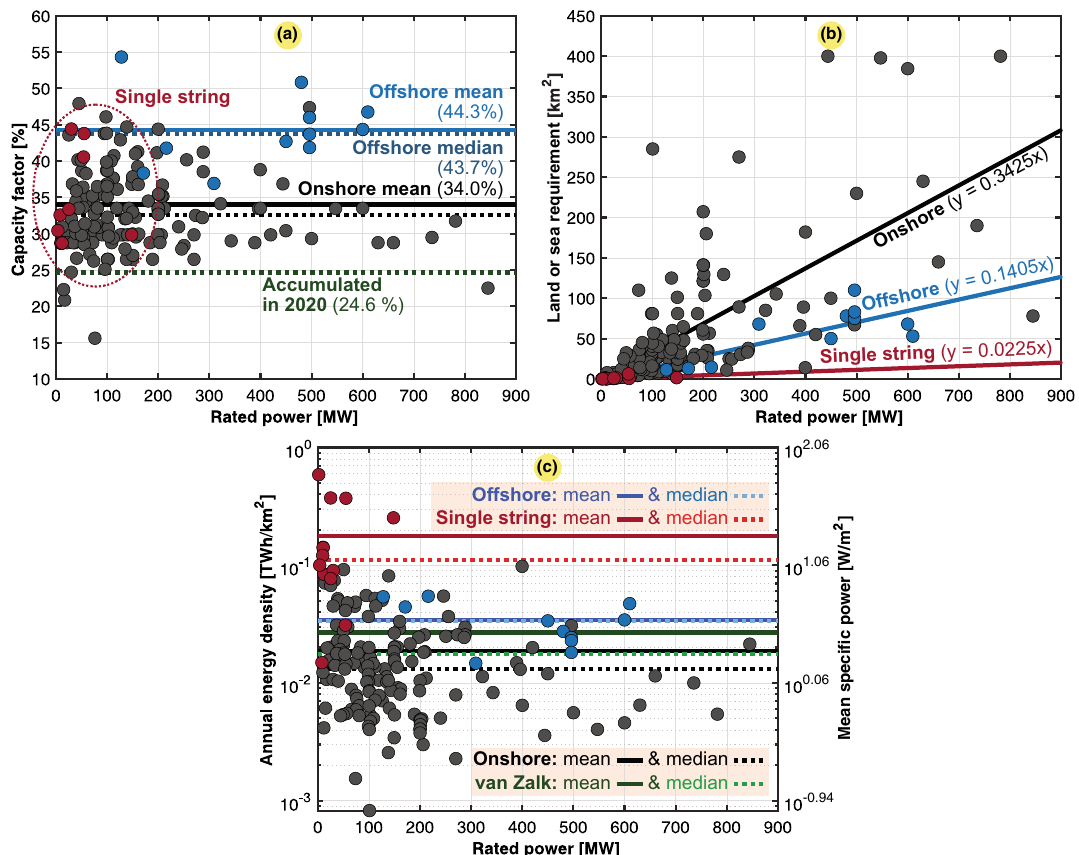
Figure 10. Worldwide study of 173 wind farms ( n = 173 ), where 148 are onshore regular farms (4 in Africa, 3 in Latin America, 77 in North America, 53 in Europe, and 11 in Asia Pacific), 14 are single-string farms, and 11 are offshore farms. Typical, mean, median, and fitted values are also included. ( a ) Capacity factor ( C g ). ( b ) Land use ( A g ). ( c ) Annual energy density ( ε g ) or mean specific power ( p g ) with van Zalk and Behrens 3 as a reference.